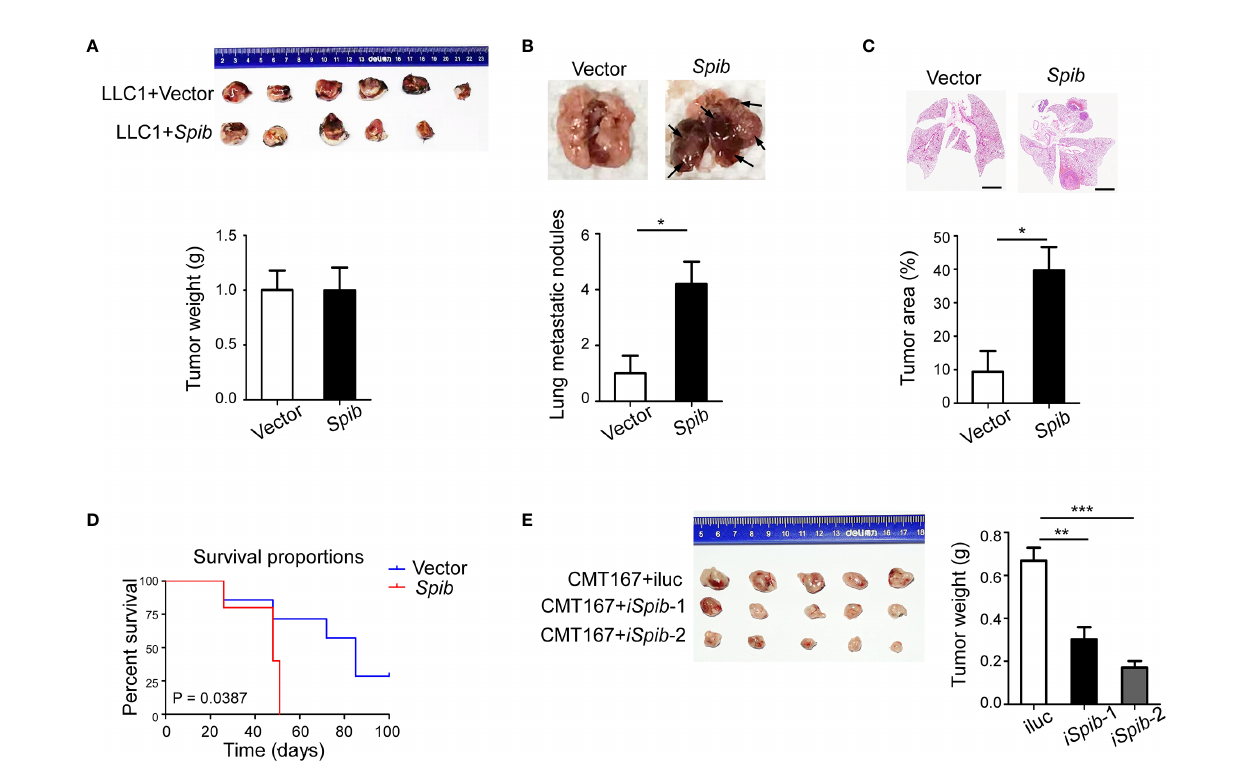
FIGURE 1 | Spib overexpression promotes lung cancer progression in subcutaneous mouse models. (A) Subcutaneous tumors in situ were excised 2 weeks after inoculation with LLC1 cells expressing empty vector or Spib . Upper panel, images of subcutaneous tumors. Lower panel, tumor weight. (B) The mice were sacri fi ced and lung metastases were analyzed 6 weeks after inoculation with LLC1 cells expressing empty vector or Spib (n = 5). Upper panel, representative images of lungs. Black arrow, metastatic nodules. Lower panel, quantitation of lung metastatic nodules. (C) H&E staining of lungs from mice subcutaneously injected with vector or Spib -expressing LLC1 cells (n = 5). Scale bars, 2 mm. Upper panel, representative H&E staining in lungs. Lower panel, the tumor burden was measured as the percentage of the tumor area versus the total lung area. (D) Kaplan-Meier survival curve of mice subcutaneously injected with vector or Spib -expressing LLC1 cells. Survival between LLC1 cells expressing empty vector and LLC1 cells expressing Spib was signi fi cantly different (P < 0.05; n = 6, vector; and n = 5, Spib ). (E) CMT167 cells expressing control or shRNA against Spib were subcutaneously injected into C57BL/6 mice. Two weeks later, subcutaneous tumors were removed. Left, images of subcutaneous tumors. Right, tumor weight. Mean ± SD. *P < 0.05. **P < 0.01. ***P <